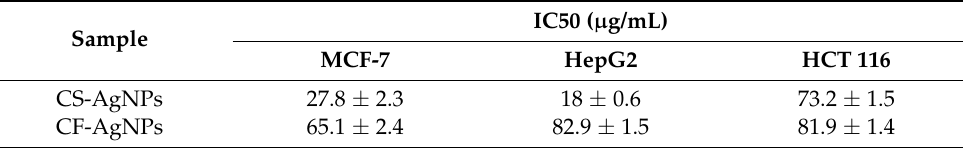
Table 2. The IC 50 ( µ g/mL) of the biosynthesized AgNPs from the cell supernatant (CS-AgNPs)